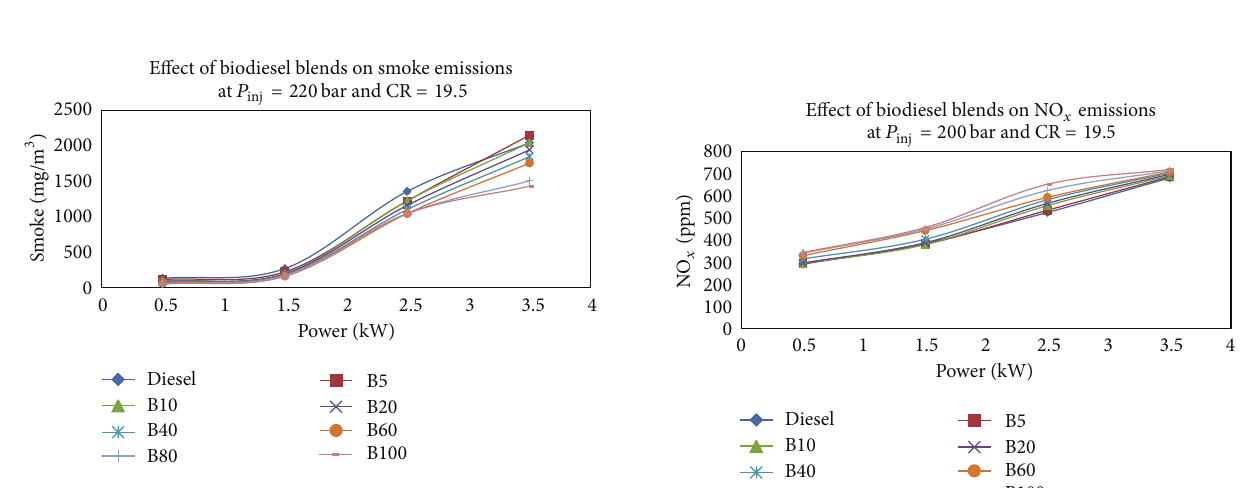
Figure 16: Variation in smoke opacity for various biodiesel blends 200 bar and CR 19.5. at 𝑃 inj